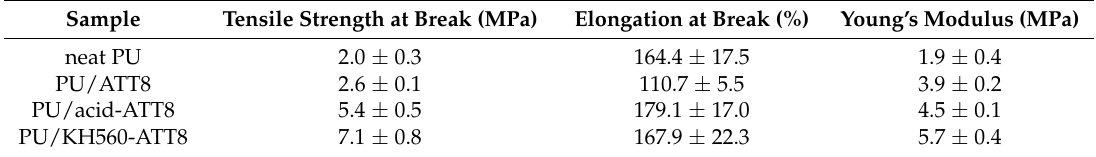
Figure 3. ( a ) Stress-strain curves of neat PU and PU nanocomposites containing 8 wt % ATT, acid-ATT and KH560-ATT; ( b ) effect of different ATTs on the tensile strength and Young’s modulus of PU nanocomposites containing 8 wt % ATT, acid-ATT and KH560-ATT. Table 2. Mechanical properties of neat PU and PU nanocomposites containing 8 wt % ATT, acid-ATT and